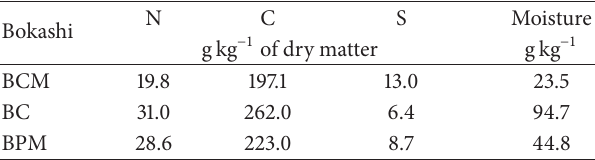
Table 1: Contents of nitrogen (N), carbon (C), sulfur (S), and moisture of the three EM Bokashis used in the